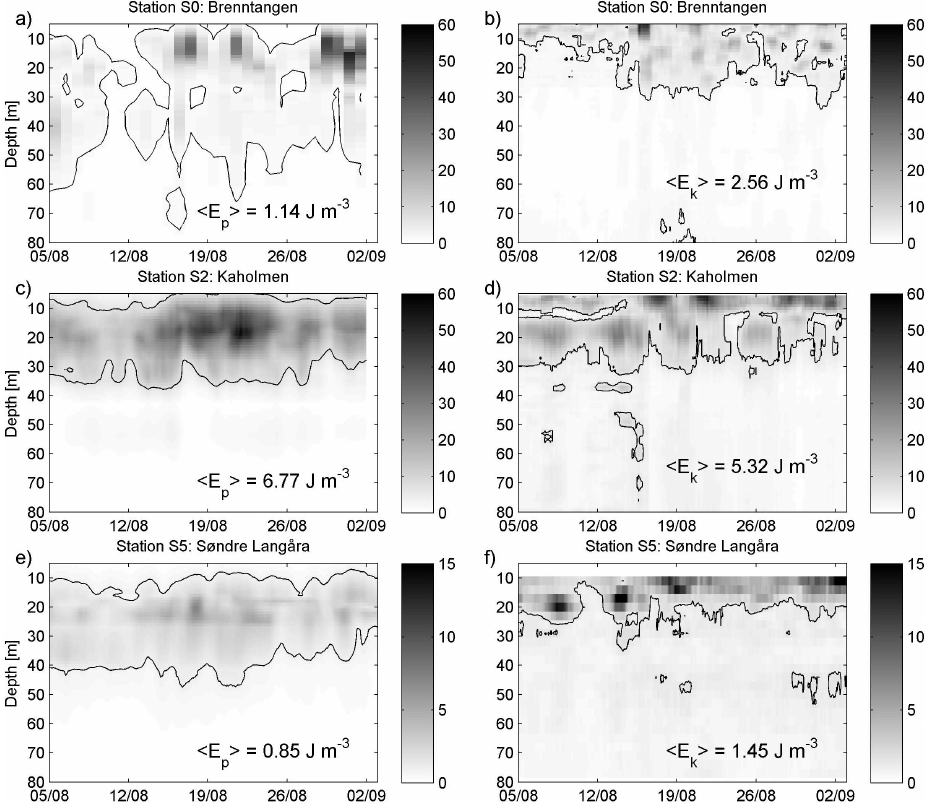
Fig. 11. Baroclinic energy densities are shown with a grey scale where darker shades indicate higher values in unit Jm − 3 for stations S0 ( (a) and (b) ), S2 ( (c) and (d) ) and S5 ( (e) and (f) ). Potential energy density E p (Eq. 11) is shown to the left and kinetic energy density E k (Eq. 12) to the right. A sliding mean with period of 25 hours is applied to cancel out the tidal oscillations. The average of the energy densities (cid:10) E (cid:11) and h E p k i for the whole period and for all depths is indicated with a number, and a contour line with this value is drawn in each